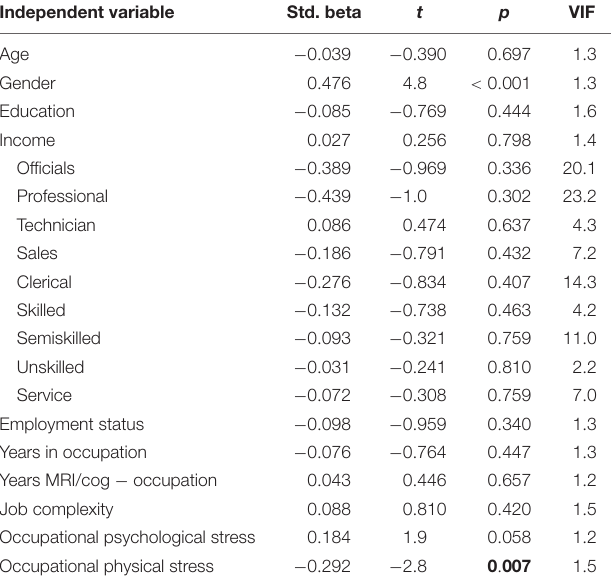
TABLE 4 | Occupational correlates of